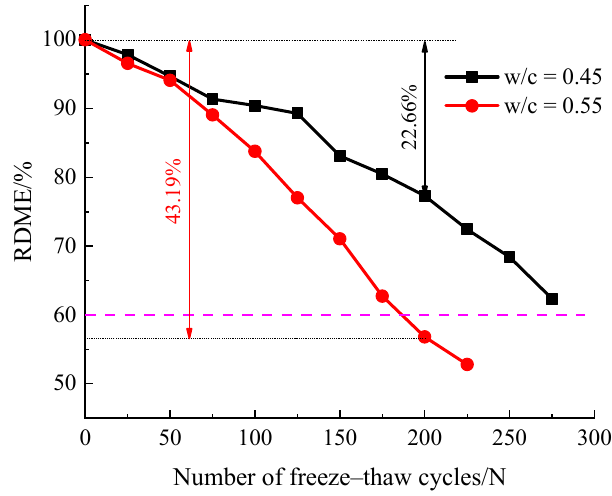
Figure 10. Variation of RDME with different freeze–thaw cycles.